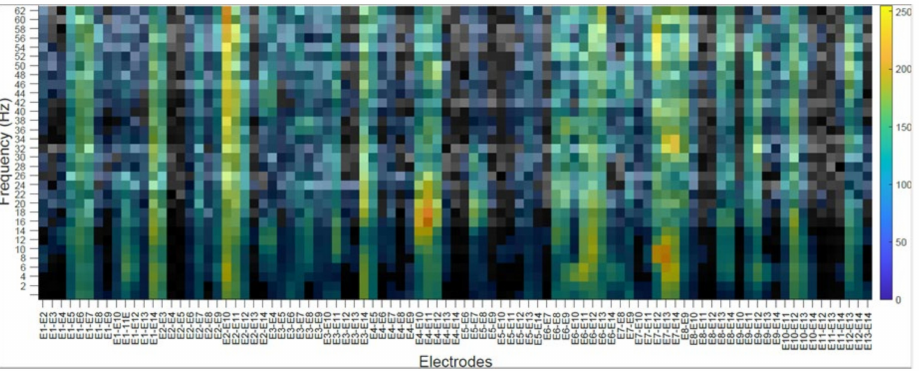
Figure 12. Subjects’ internal representation (CAM) in imagined tasks of the vowel /u/. The horizontal axis represents the difference between electrodes and the vertical axis, the corresponding